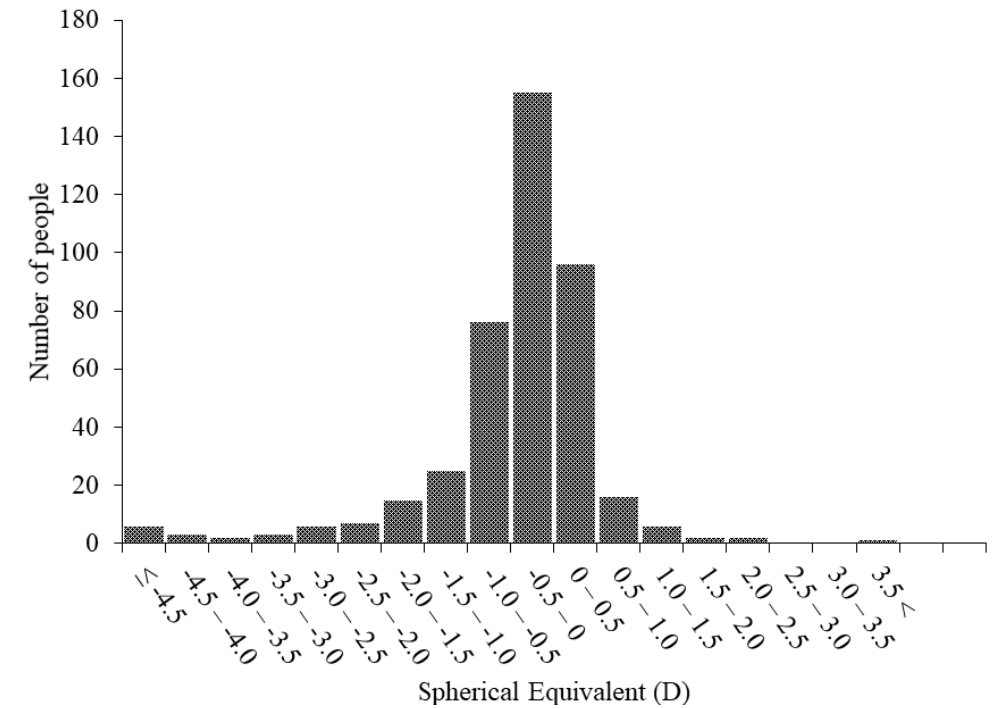
Figure 2. The distribution of SE. The participants in this study were primarily emmetropic (average, − 0.44 diopters). Abbreviations: SE, spherical equivalent; D, diopters.